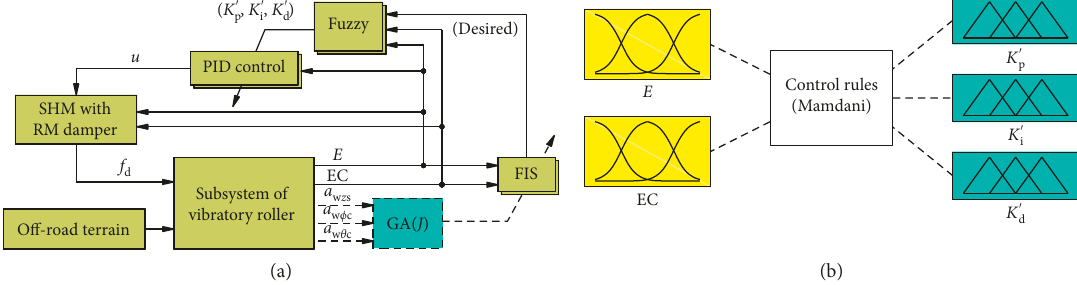
Figure 5: Structure of the vehicle model with SHM. (a) Optimal fuzzy-PID control model. (b) FLC control.